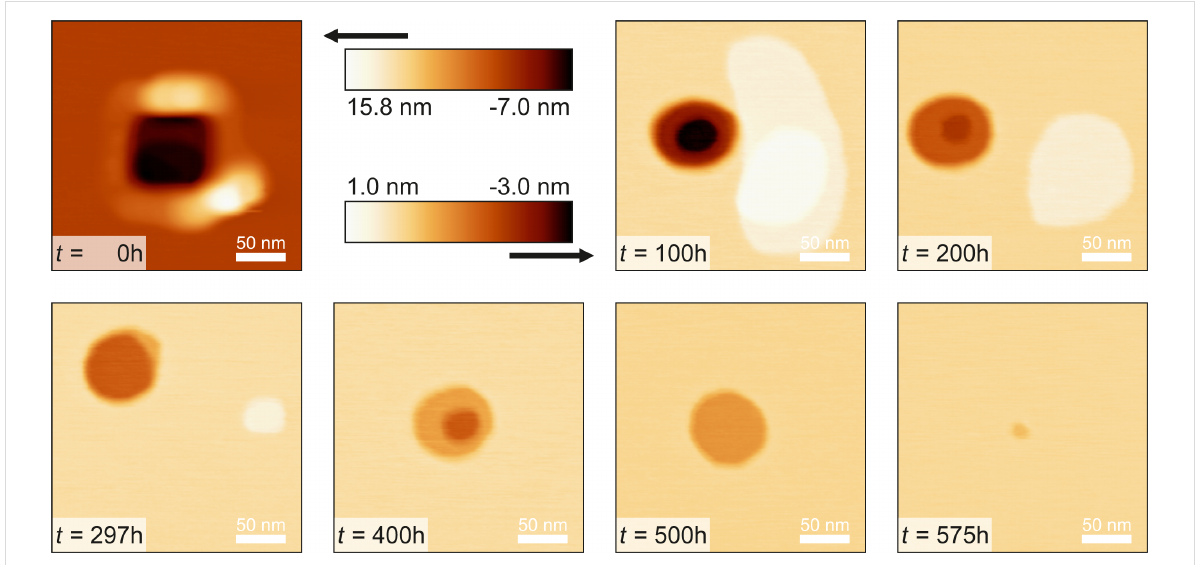
Figure 6: 250 nm × 250 nm images of the time evolution of both defect and accumulation at different consecutive times. It can be observed that both hole and accumulation turned in a round shape. For better visibility the first image at t = 0 shows a different color scale.